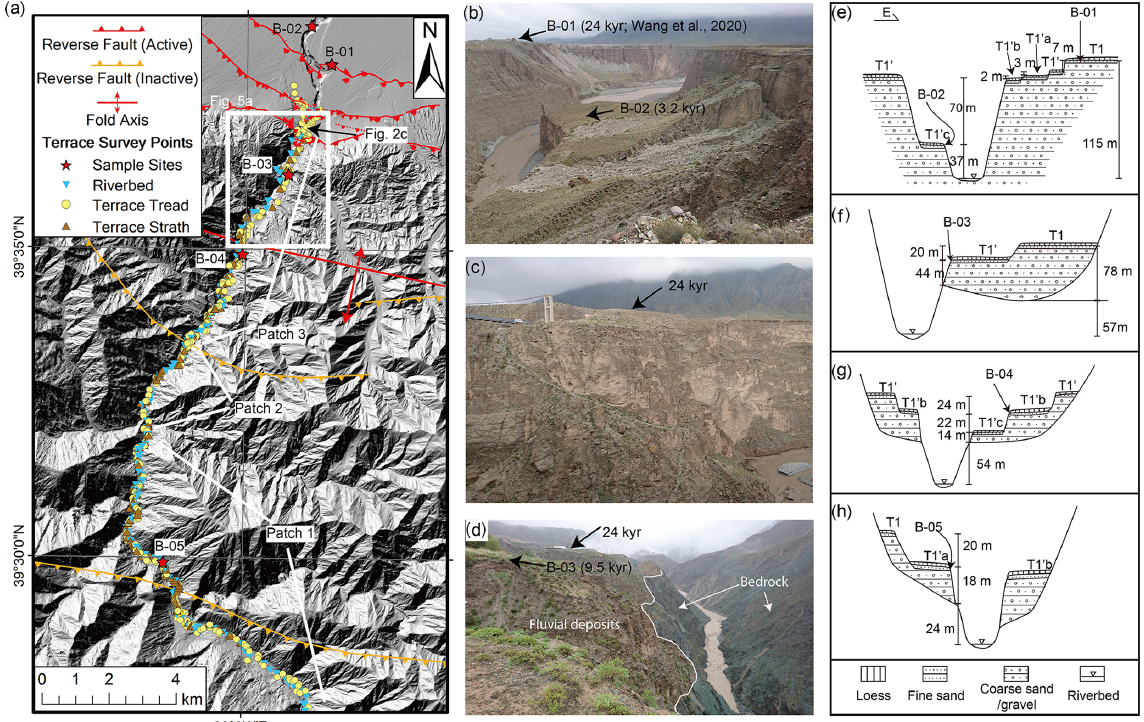
Figure 2. (a) Map of the Beida River within the North Qilian Shan, with survey points and geochronology sample sites indicated. (b) Photo of Beida River canyon and sample site B-01 AND B-02 within the foreland, looking upstream. Thick layers of gravel are exposed on the canyon walls. (c) Photo of Beida River canyon and T1 terraces near the mountain front, looking east (location in Fig. 2a). In this photo, the 24kyr T1 terrace tread is ∼ 40m above the 9.5kyr T1’ terrace tread. (d) Photo of Beida River canyon and sample site B-03 inside the mountains, looking upstream. This photo shows that the Beida River deeply incises into the bedrock below the terrace fill. (e–h) Cross sections of the Beida River terraces at each sample site, facing downstream. Note that labels a, b, and c indicate local terrace ordering and cannot be directly correlated to terraces upstream and